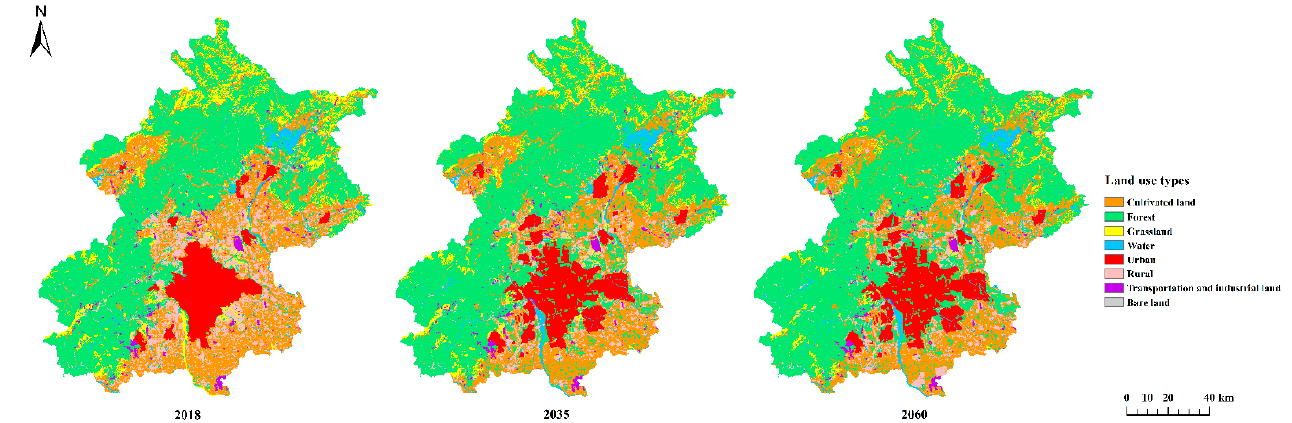
Figure 7. Land use maps in Beijing from 2018 to the two planned scenarios (in 2035 and 2060).